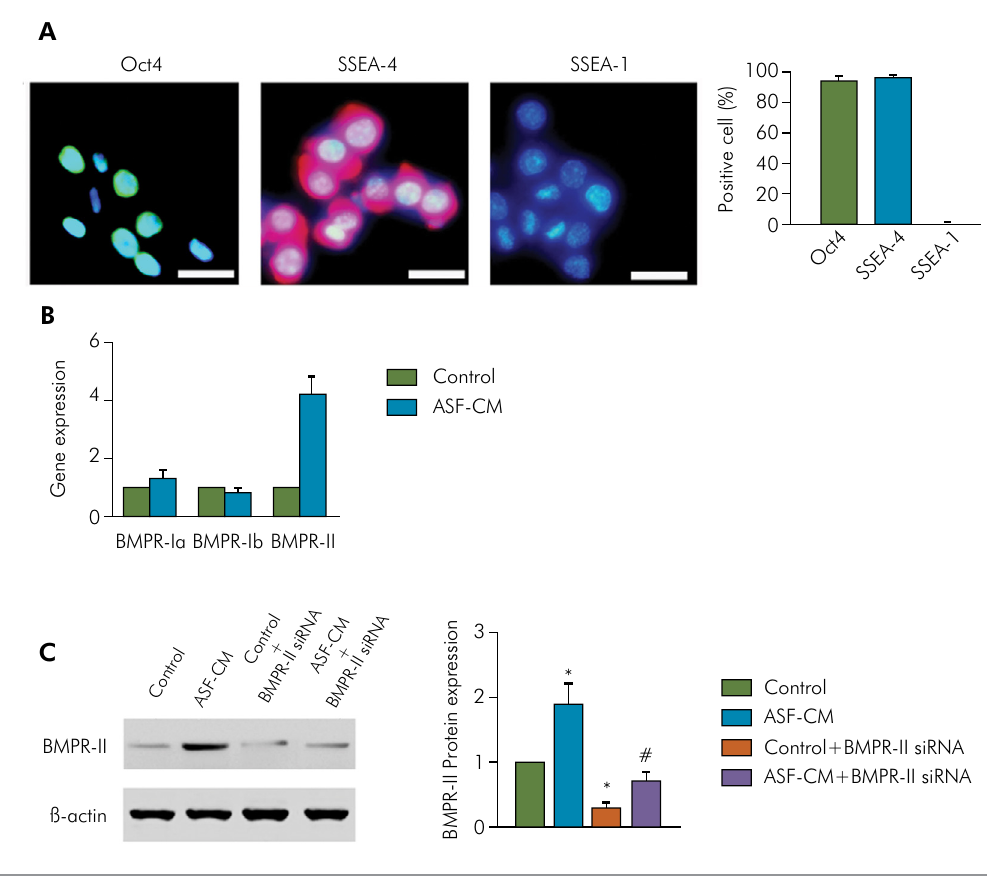
Figure 1. Characterization of mouse iPS cells and the gene and protein levels of BMP receptors in iPS cells induced by the epithelial cell medium (Control) and ameloblast-conditioned medium (ASF-CM). A: The immunofluorescent staining and cell counting of the expression of OCT4, SSEA-4 and SSEA-1 by iPS cells. B: RT-PCR analysis of the gene expression of BMP receptors in iPS cells induced by the control medium and ASF-CM. C: Western blotting analysis and quantification of the protein levels of BMPR-II in iPS cells induced by the control medium, ASF-CM, control medium+BMPR-II siRNA, or ASF-CM+BMPR-II siRNA. Scale bar represents 50 μ m. *p < 0.05, vs . control group. # P < 0.05, vs . ASF-CM group. Characterization of the ameloblasts used to prepare serum-free conditioned medium (ASF-CM). Immunofluorescent staining showed that almost all cells are positive for the ameloblastic makers (ameloblastin and enamelin). Scale bar represents 25 μ